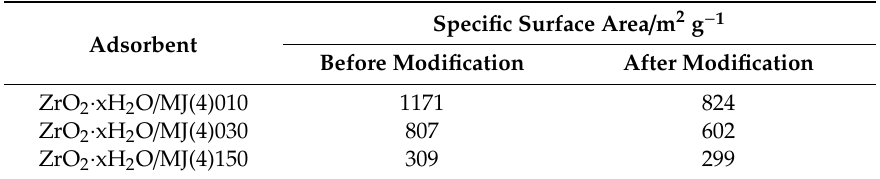
Table 2. Measuredspecificsurfaceareasofthepreparedadsorbentsandtheunmodifiedmesoporouscarbons.